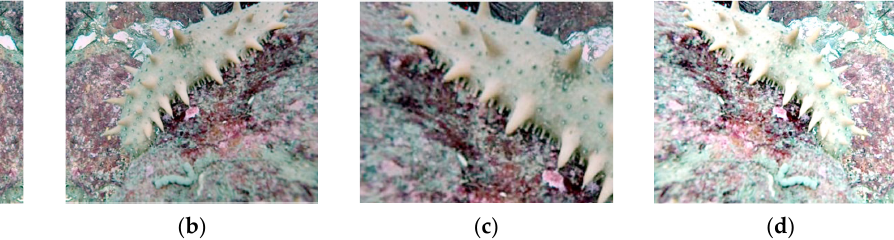
Figure 4. Image ( a ) is the original image, image ( b ) is after image flipping, image ( c ) is after ran- domly enlarged, and image ( d ) is after brightness change processing. enlarged, and image ( d ) is after brightness change